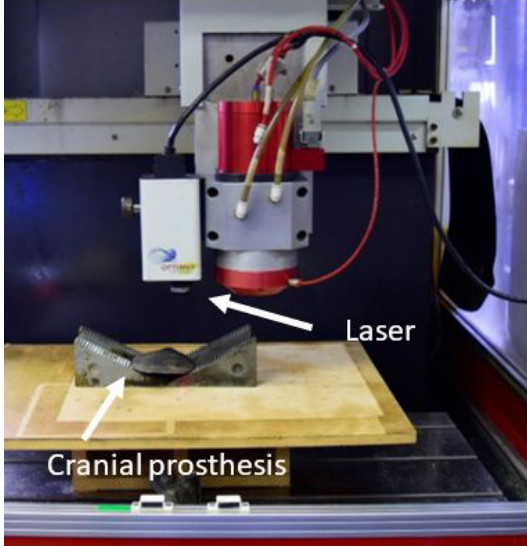
Figure 3. Geometric discrepancy analysis based on the laser incidence (LdSM). Table 1. Composition of O obtained from the EDS Mapping for the surface of samples before and after UVC irradiation.